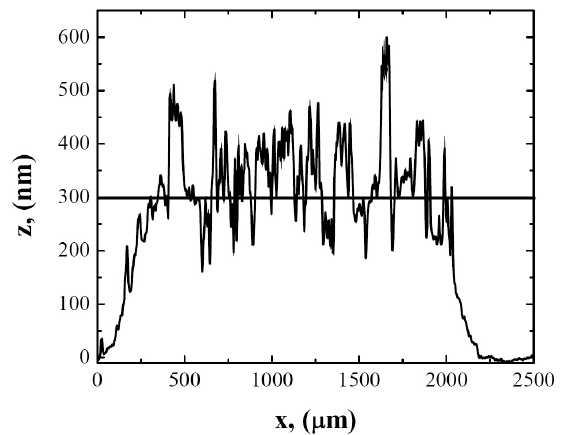
Figure 4: Typical profile of a deposited film. Substrate was treated 60 seconds in 0.01 M Zn(NO distance between the nozzle and solution level – 3 mm.